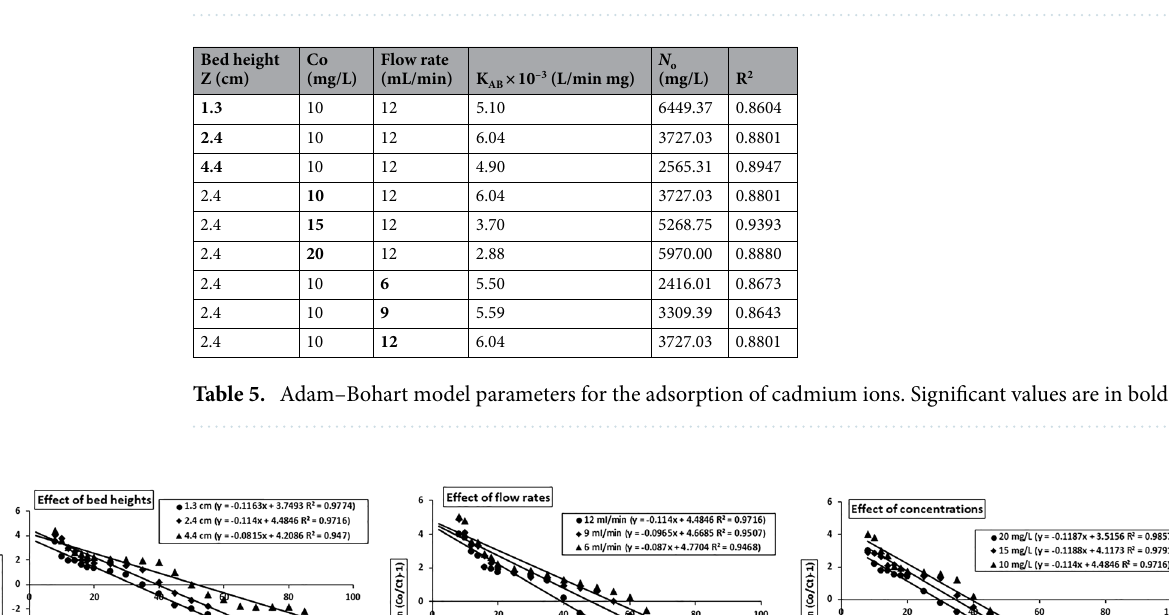
Figure 9. Adam–Bohart model linear fitting curve for bed heights, flow rates and concentrations. The dots indicate experimental results while the lines show model fit.